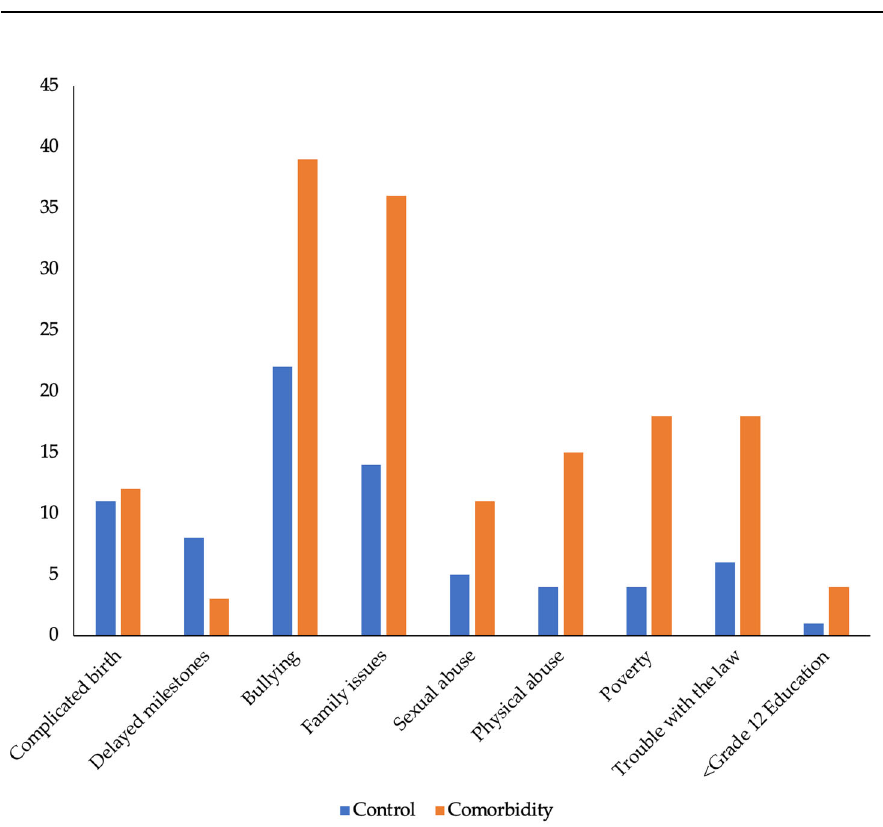
Figure 1. Number of reported specific risk factors as compared to principal diagnosis.